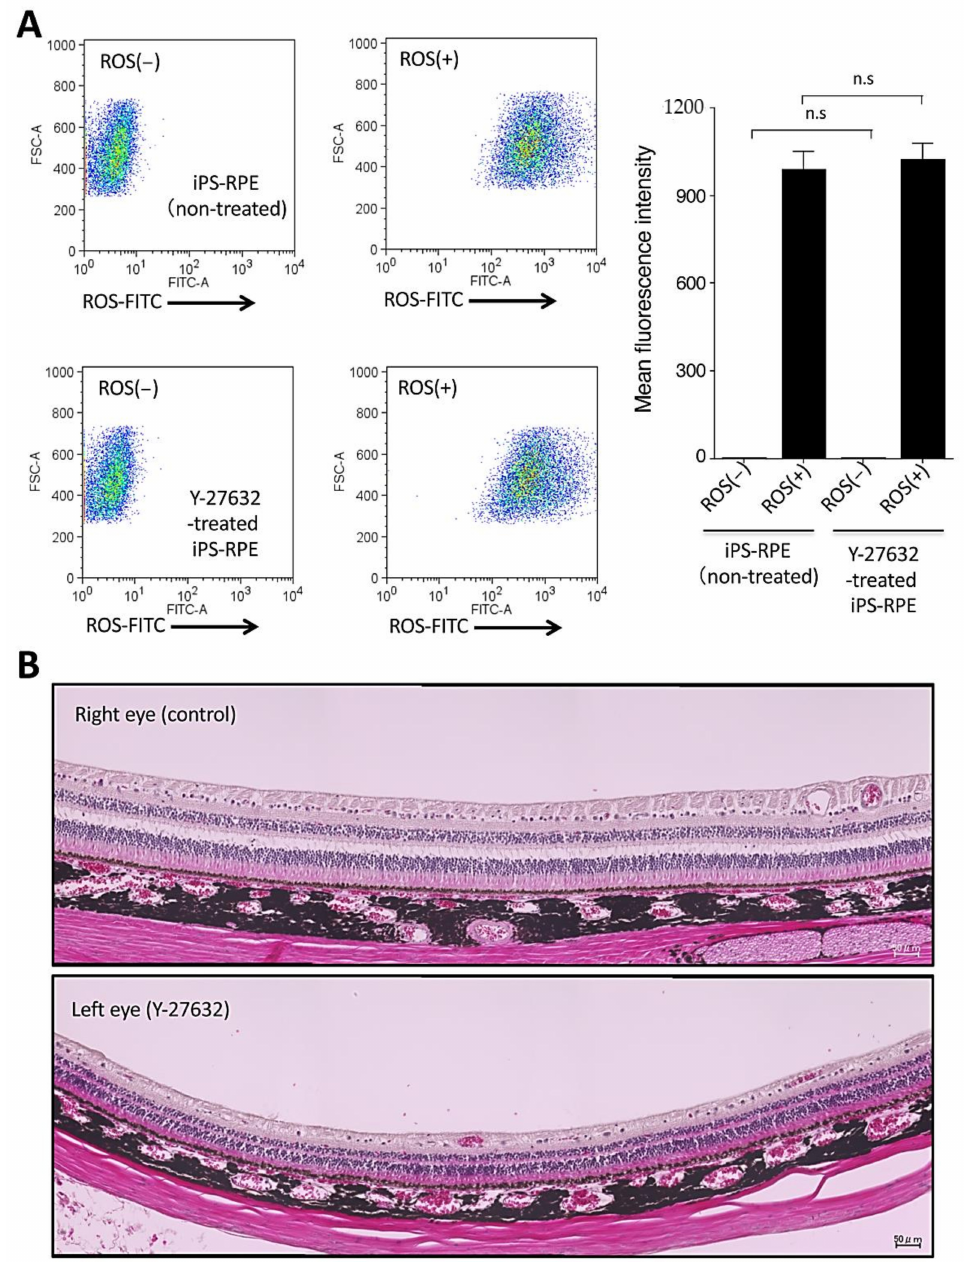
Figure 4. Toxicity of iPS-RPE cells and retinal cells by Y-27632 treatment. ( A ) Measurement of phagocytosis by Y-27632- treated iPS-RPE cells (253G1 lines). iPS-RPE cells were cultured with FITC-labeled porcine shed photoreceptor rod outer segments (ROS) at 37 ◦ C for 24 h and analyzed using flow cytometry. Control cells, which were iPS-RPE cells cultured without FITC-ROS, were used to obtain baseline fluorescence (left graphs), and iPS-RPE cells without ROS at 37 ◦ C were also analyzed. The right panel shows that there were no significant differences between Y-27632-treated vs. nontreated RPE cells in the expression of FITC-ROS. Data represent the mean ± SEM of three independent experiments, and we obtained similar results with other iPS-RPE cell lines (TLHD2 lines). n.s., not significant. ( B ) Toxicity of in vivo retinas in a cynomolgus monkey by Y-27632 treatment. We administrated Y-27632 in saline into the left eye, and saline only as a control into the right eye, and evaluated the retinas including the RPE layer using H&E staining of retinal sections. Similar to control retina ( upper ), retinal sections with Y-27632 administration showed no damage with H&E staining ( lower